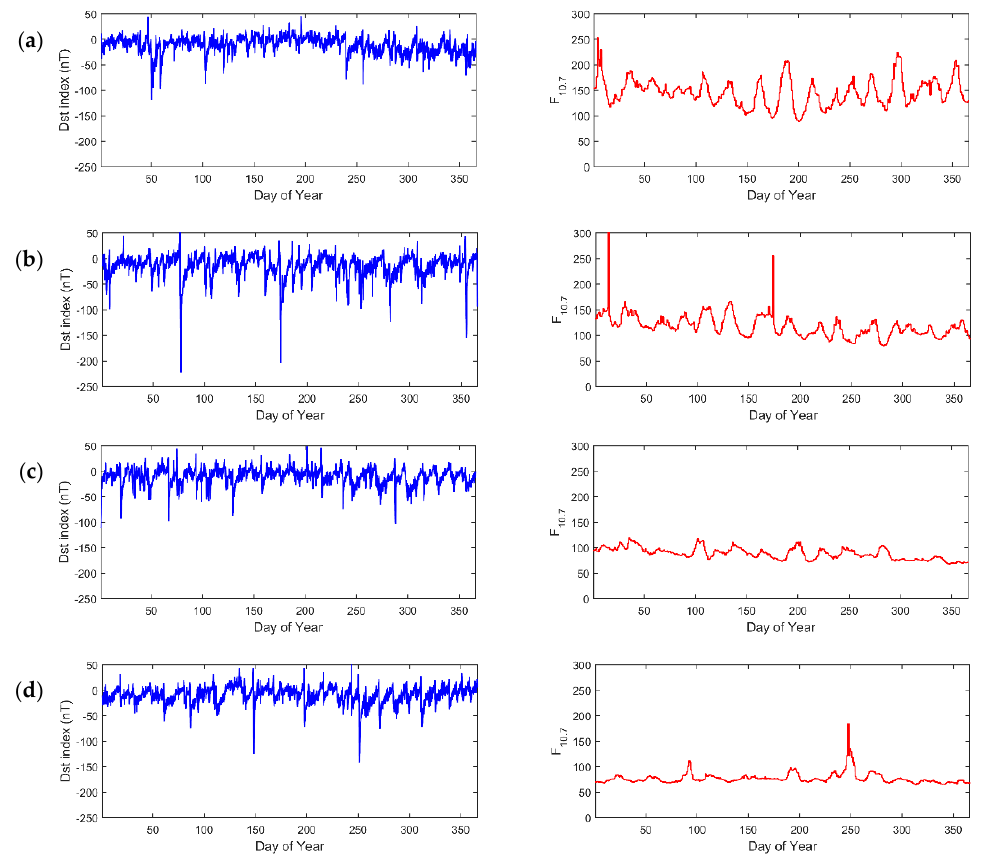
Figure 11. Dst and F 10.7 indices for the period of 1 to 365 of 2014 ( a ), 2015 ( b ), 2016 ( c ) and 2017 ( d ).